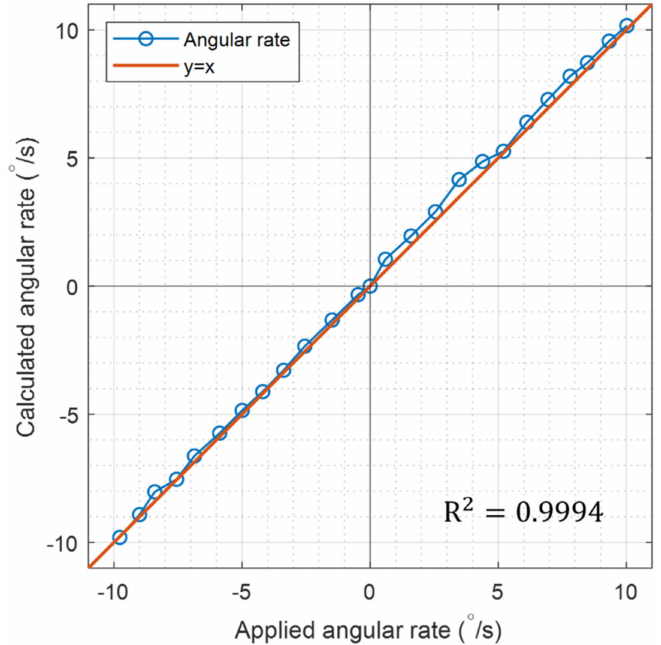
Figure 9. The comparison of the applied angular rate and the measured angular rate. They are well matched with the coefficient of determination of R 2 = 0.9994.